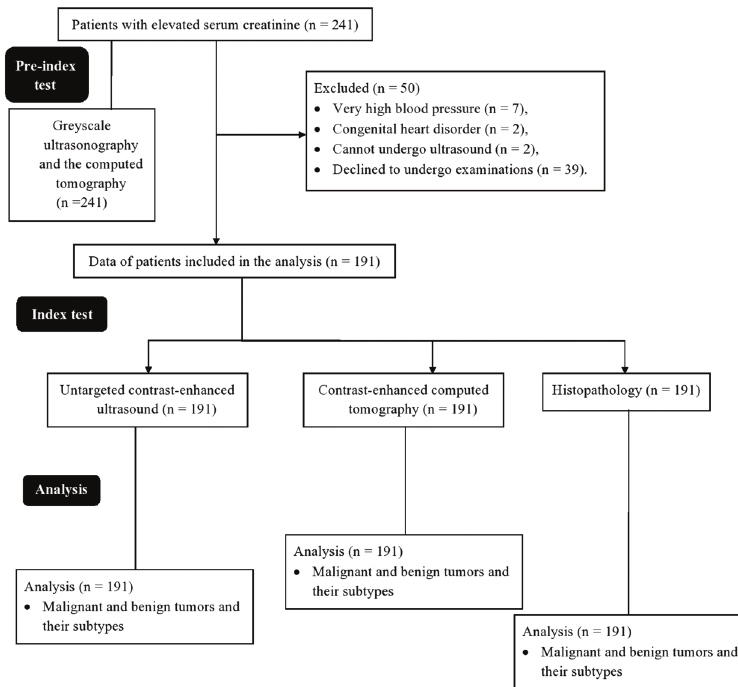
Figure 5 - Flow diagram of the study.